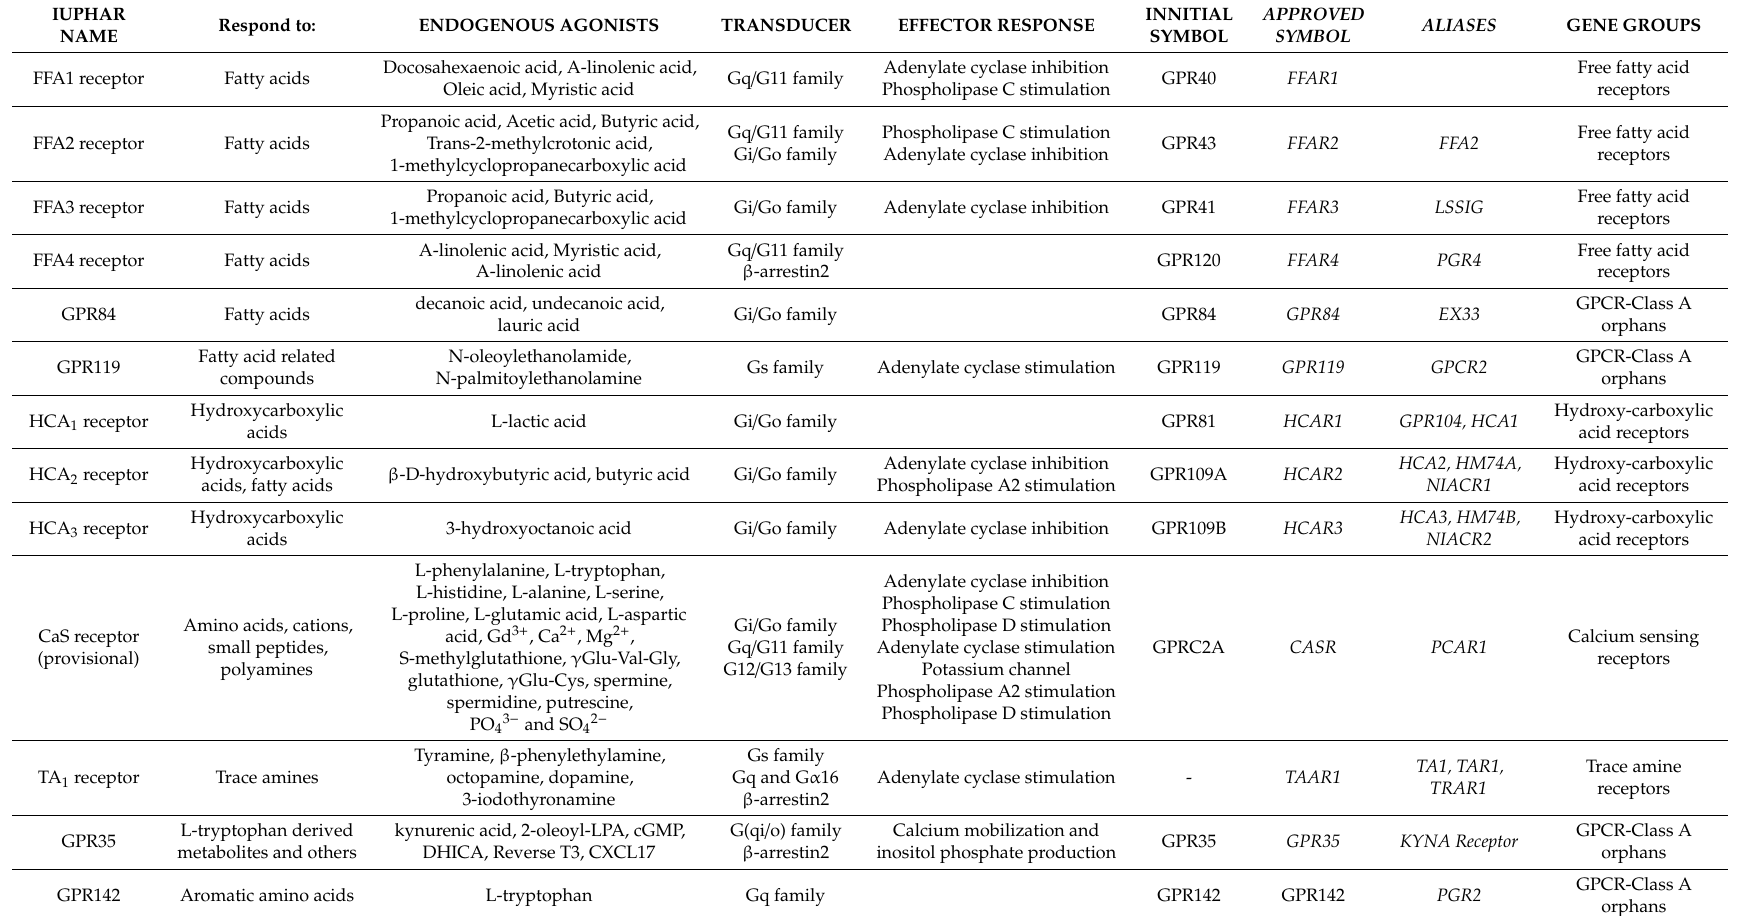
Table 1. Classification of metabolite sensing-G-protein-coupled receptors (GPCRs) according the nature of their specific agonists. This table includes the specific endogenous agonists reported so far, the G proteins linked to each receptor, and the information about the corresponding gene (approved symbol, aliases, and name of the gene group) [16]. (FFA, free fatty acid; FFAR, free fatty acid receptor; HCA, hydroxycarboxylic acid; TA, trace amines; CaS receptor, calcium sensing